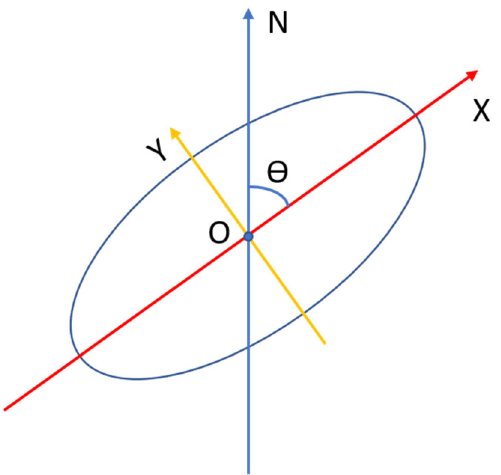
Figure 3. Standard deviational ellipse. Where X represents the direction of long axis, Y represents the direction of short axis, N represents North, O represents the center of SDE, and θ represents the rotation angle of SDE.